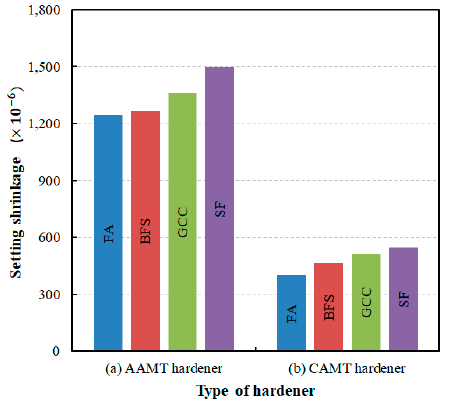
Figure 9. Setting shrinkage by hardener and filler type.